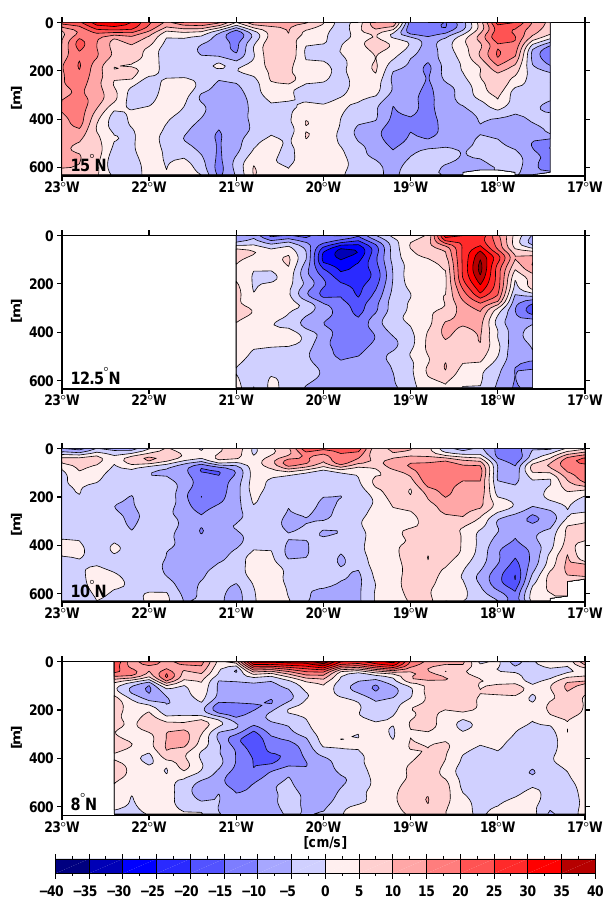
Figure 5. Meridional velocity component in cms − 1 (positive north- ward) at about 15 ◦ N east of 23 ◦ W, at 12.5 ◦ N east of 21 ◦ W, at 10 ◦ N east of 23 ◦ W, and at 8 ◦ N east of 22.4 ◦ W and west of 17 ◦ W, all measured in October 2010 (cruise tracks can be seen in Fig. 11).